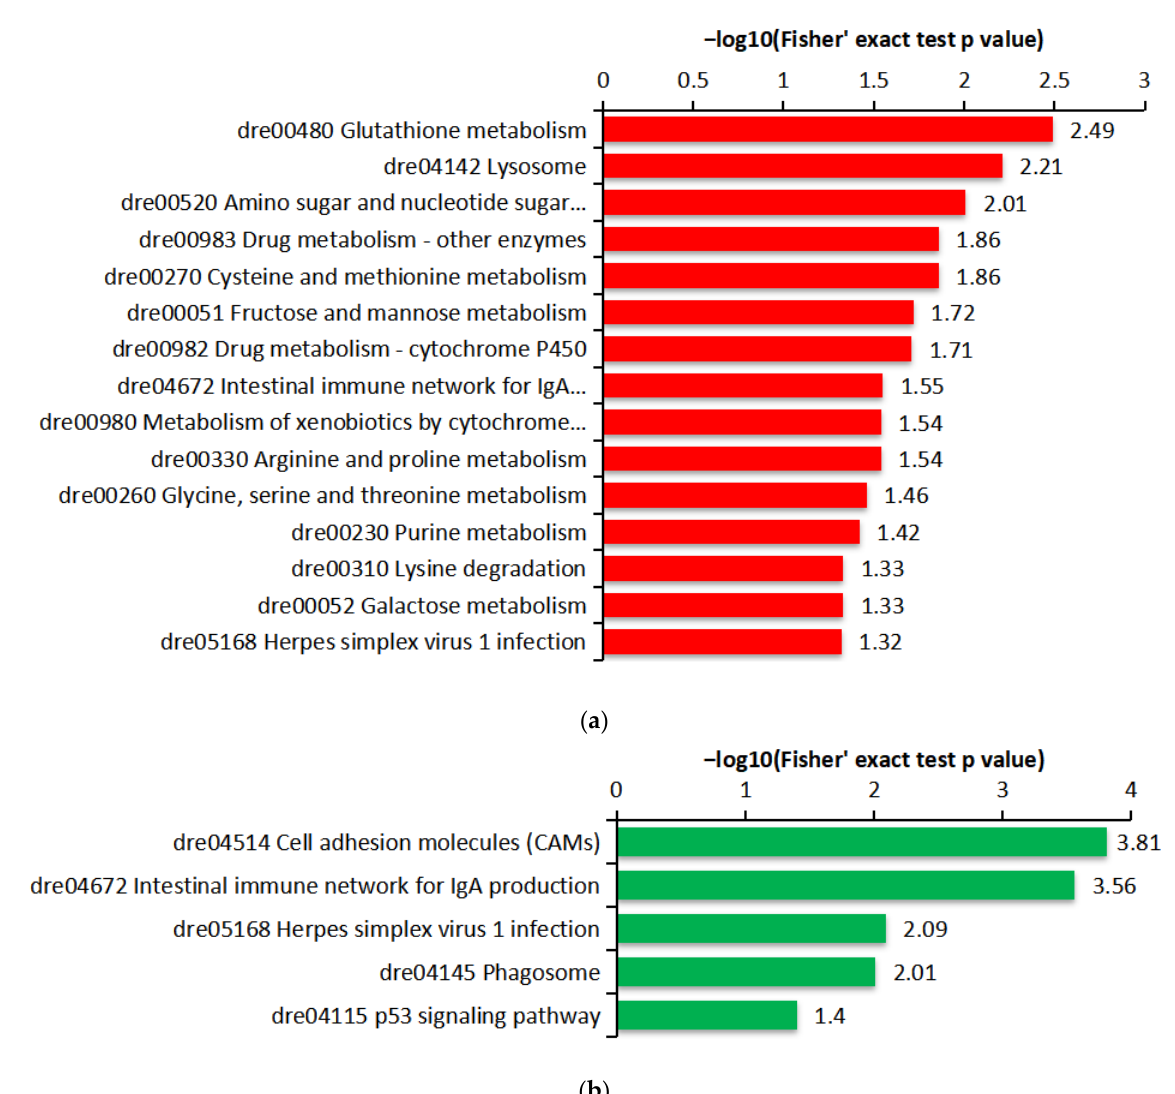
Figure 7. KEGG pathway enrichment analysis of the DEPs: ( a ) KEGG enrichment analysis of the up-regulated proteins; ( b ) KEGG enrichment analysis of the down-regulated proteins.